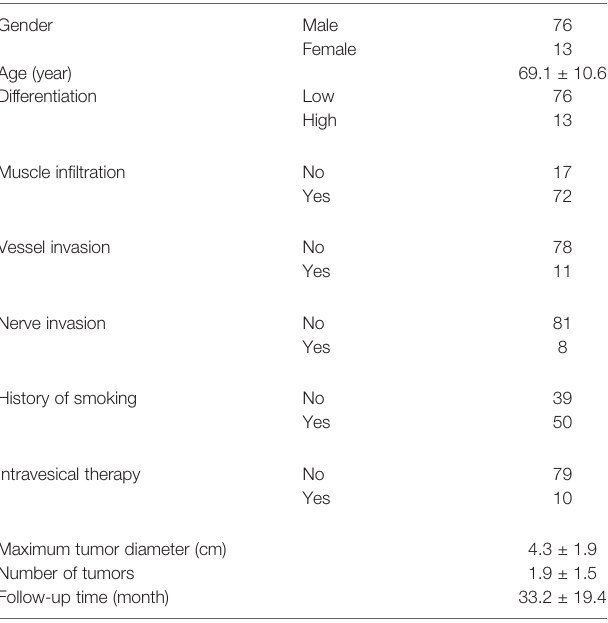
TABLE 1 | Baseline information.